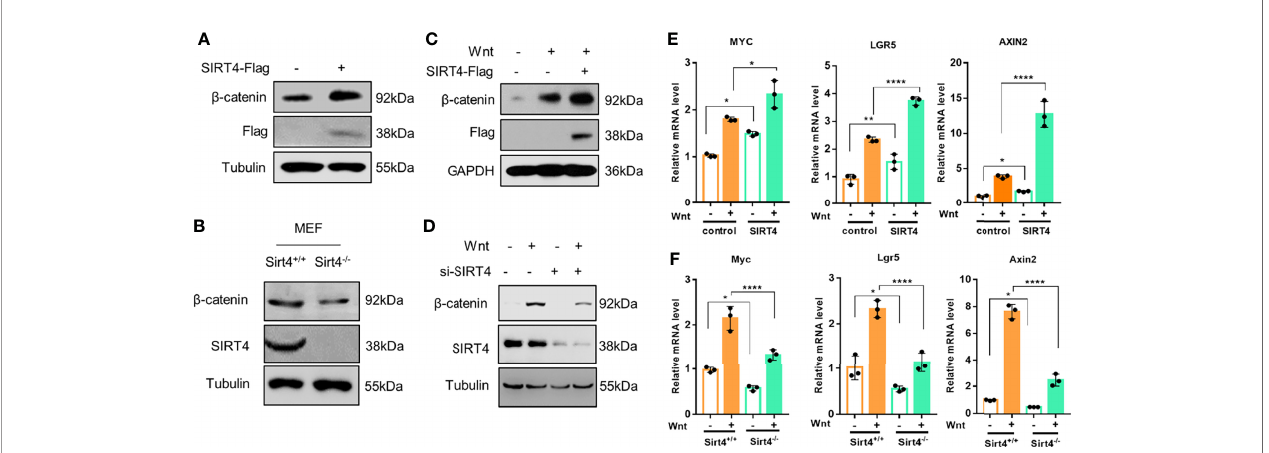
FIGURE 3 | SIRT4 positively regulates the Wnt/ b -catenin signaling pathway. (A) HEK293T cells were transfected with EV and SIRT4-Flag respectively, the cells were collected and the whole cell lysates were analyzed by western blot with the indicated antibodies. (B) Sirt4 +/+ MEFs and Sirt4 − / − MEFs were prepared from WT and Sirt4 knockout mice respectively and maintained in DMEM with 10% FBS. Whole cell lysates were analyzed by western blot with the indicated antibodies. (C) HEK293T cells were transfected with EV or SIRT4-Flag, the cells were treated with Wnt3a-conditioned medium for 30 min. The whole cell lysates were analyzed by western blot with the indicated antibodies. (D) HEK293T cells were transfected with/without siSIRT4 for 48 h, then the cells were treated with Wnt3a-conditioned medium for 30 min. The whole cell lysates were analyzed by western blot with the indicated antibodies. (E) HEK293T cells were transfected with EV and SIRT4-Flag respectively, the cells were treated with Wnt3a- conditioned medium for 3 h. Total RNA was extracted with TRIzol, and the mRNA levels of b -catenin target genes (AXIN2, LGR5 and MYC) were analyzed with RT-qPCR (n = 3; error bars represent ± SD, *p < 0.05, **p < 0.01, ****p < 0.0001; two-way ANOVA with multiple comparisons followed by Bonferroni post hoc test). (F) Sirt4 +/+ MEFs and Sirt4 − / − MEFs were stimulated with Wnt3a for 3 h. Total RNA was extracted with TRIzol, and the mRNA levels of b -catenin target genes (Axin2, Lgr5 and Myc) were analyzed with RT-qPCR (n = 3; error bars represent ± SD, *p<0.05, **** p < 0.0001; two-way ANOVA with multiple comparisons followed by Bonferroni post hoc